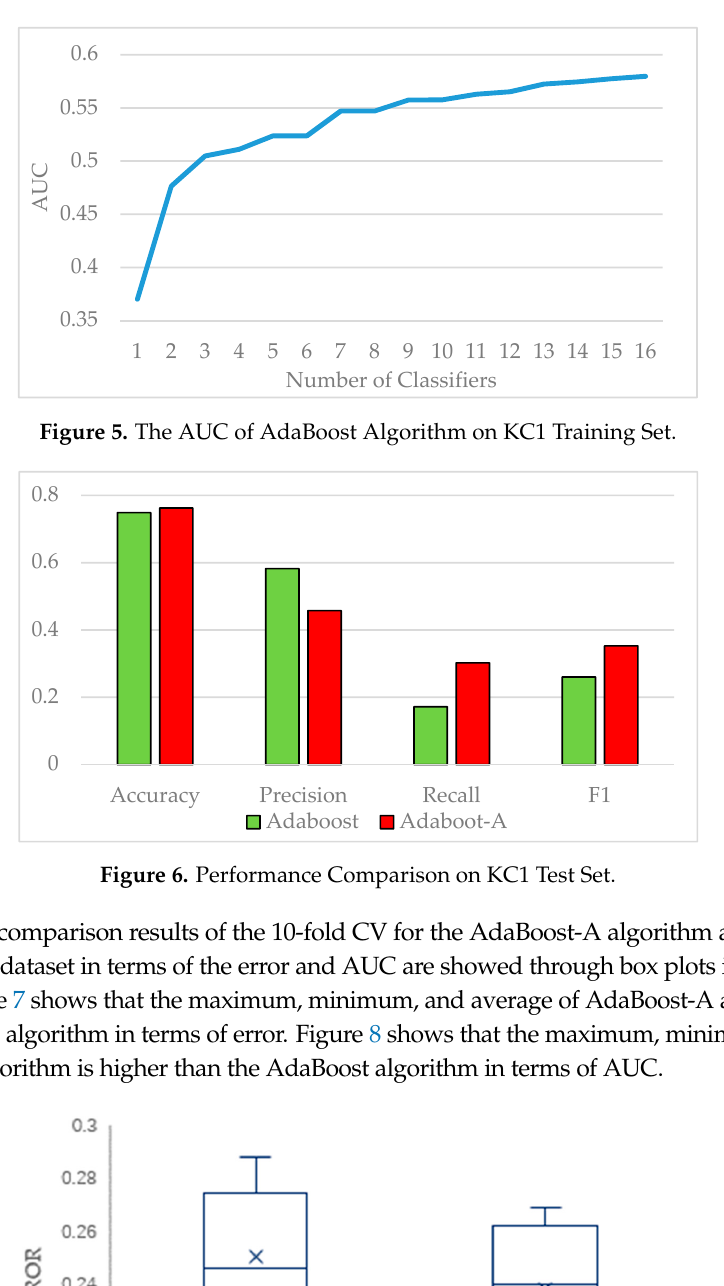
Figure 8. The AUC Comparison of AdaBoost and AdaBoost-A on KC1 Dataset. Through the above experiments, it is proved that the proposed AdaBoost-A algorithm is more effective than AdaBoost algorithm. 4.3. Analysis of the PSOPD-AdaBoost-A Ensemble Algorithm The coefficients of AdaBoost-A weak classifiers are optimized by the improved PSO based on population diversity and the standard PSO on the five imbalanced datasets, respectively. We compare classification performance of them by performing 5-fold CV. The detailed classification results of the AdaBoost, PSO-AdaBoost-A, and PSOPD-AdaBoost-A algorithms based on the average of 100 runs are showed in Figures 9–13.